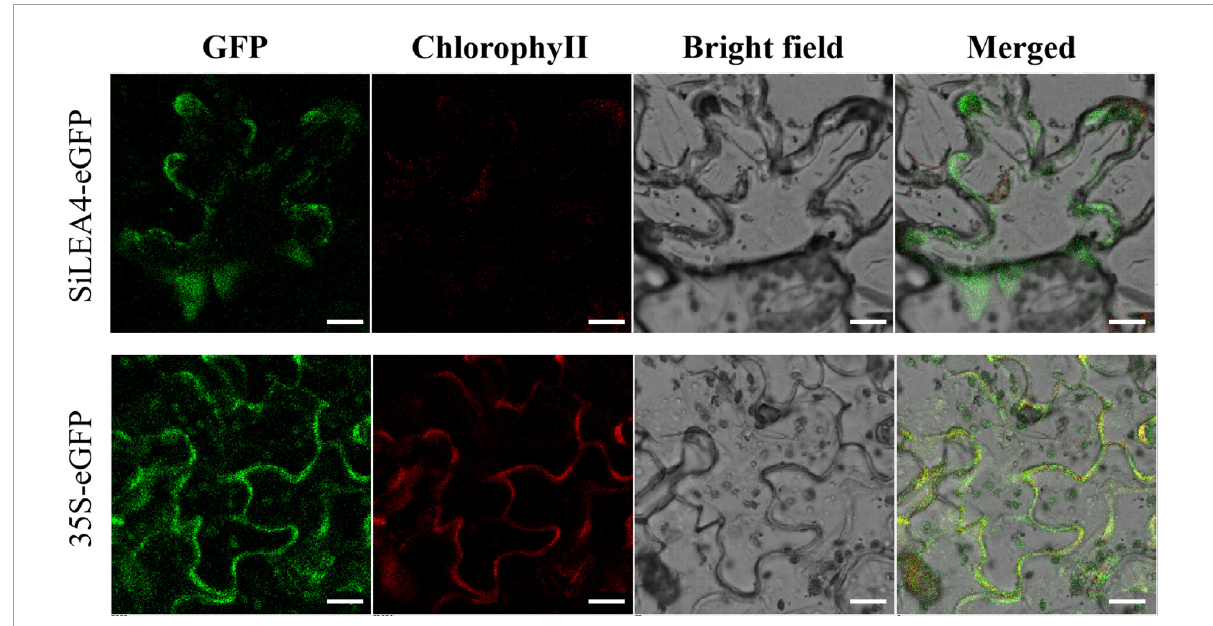
FIGURE3 Subcellular location of SiLEA4. SiLEA4 was fused to eGFP and transiently expressed in 3-week-old tobacco leaf cells. The empty vector 35S- eGFP was used as a control. A green fluorescent signal was observed with confocal microscopy 48 h after Agrobacterium infiltration. Bar = 18 µ m.